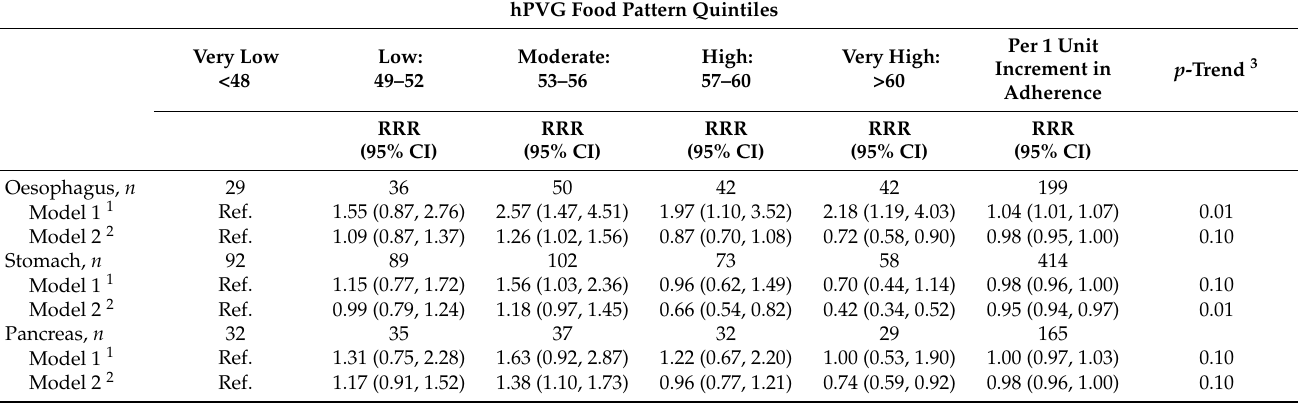
Table 4. Association between adherence to healthful PVG food pattern in quintiles and continuous (per 1 unit) and oesophageal, stomach, and pancreas cancer in participants of the PANESOES study ( n = 1233).